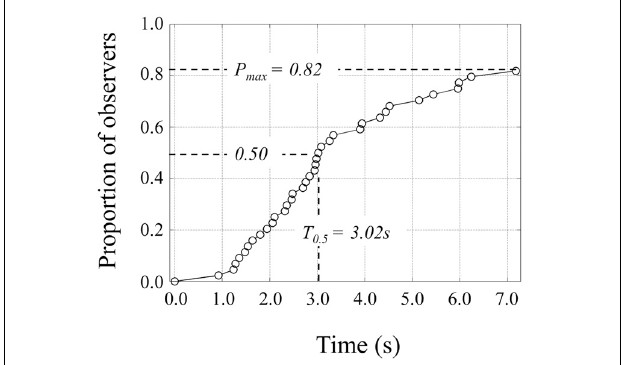
FIGURE 1 | Cumulative proportion of observers fixating a target AOI as function of time. 50% of the observers fixated the target AOI in 3.02s. The maximum proportion of observers fixating the target AOI was 0.82. We refer to this number as fixation score or P max .